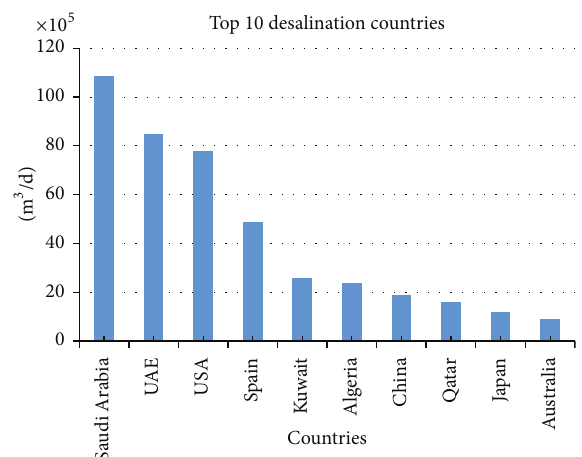
Figure 1: Desalination capacity for top 10 countries in terms of installed capacities in m 3 /d (2008)